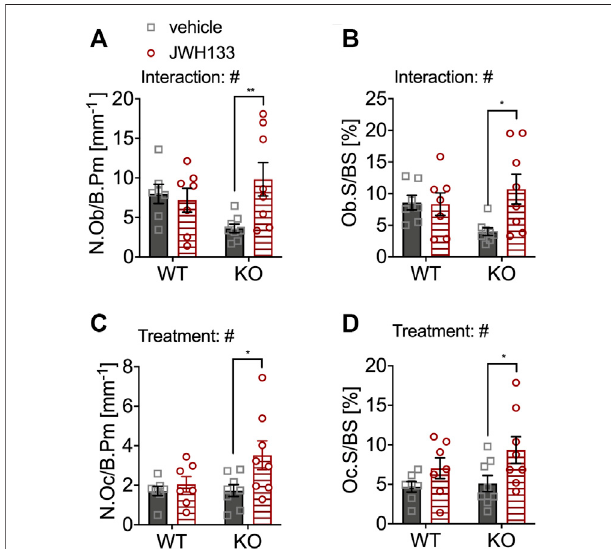
FIGURE 5 | JWH133 treatment increased the number and surface of osteoblasts and osteoclasts in p62 KO mice. (A) Number of osteoblasts per bone perimeter (N.Ob/B.Pm) was weakly reduced in p62 KO mice compared to WT mice. The treatment was only effective in p62 KO mice as it increasedthenumberofosteoblasts. (B) Osteoblastsurfaceperbonesurface (Ob.S/BS) was mildly reduced in p62 KO mice compared to WT mice. The treatment was only effective in p62 KO mice as it increased the surface of osteoblasts. (C) Number of osteoclasts per bone perimeter (N.Oc/B.Pm) was similar between genotypes but was signi fi cantly increased in p62 KO mice after JWH133 treatment. (D) Surface of osteoclasts per bone surface (Oc.S./ BS) was similar between genotypes but was signi fi cantly increased in p62 KO mice after JWH133 treatment. Male mice were aged 3 months by the beginning of the experiment and were treated for 5 days with vehicle or JWH133. Data were analyzed by using ordinary two-way ANOVA and Bonferroni adjusted p values, * p < 0.05, ** p < 0.01, *** p < 0.001. All error bars show mean ± SEM. Squares and circles represent individual data points.